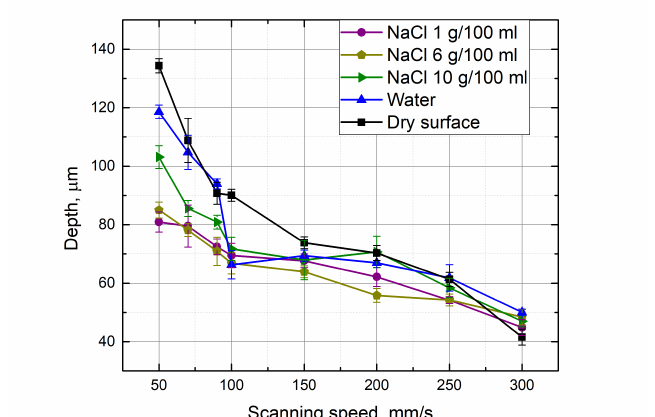
Figure 4. Depth of the grooves formed in the glass sample in dependence on the scanning speed. Grooves were formed while the glass sample surface was dry and immersed in 1 g/100 mL, 6 g/100 mL and 10 g/100 mL concentrations of NaCl aqueous solutions, and water. Number of scans—15, average power—5 W, and pulse repetition rate—60 kHz.